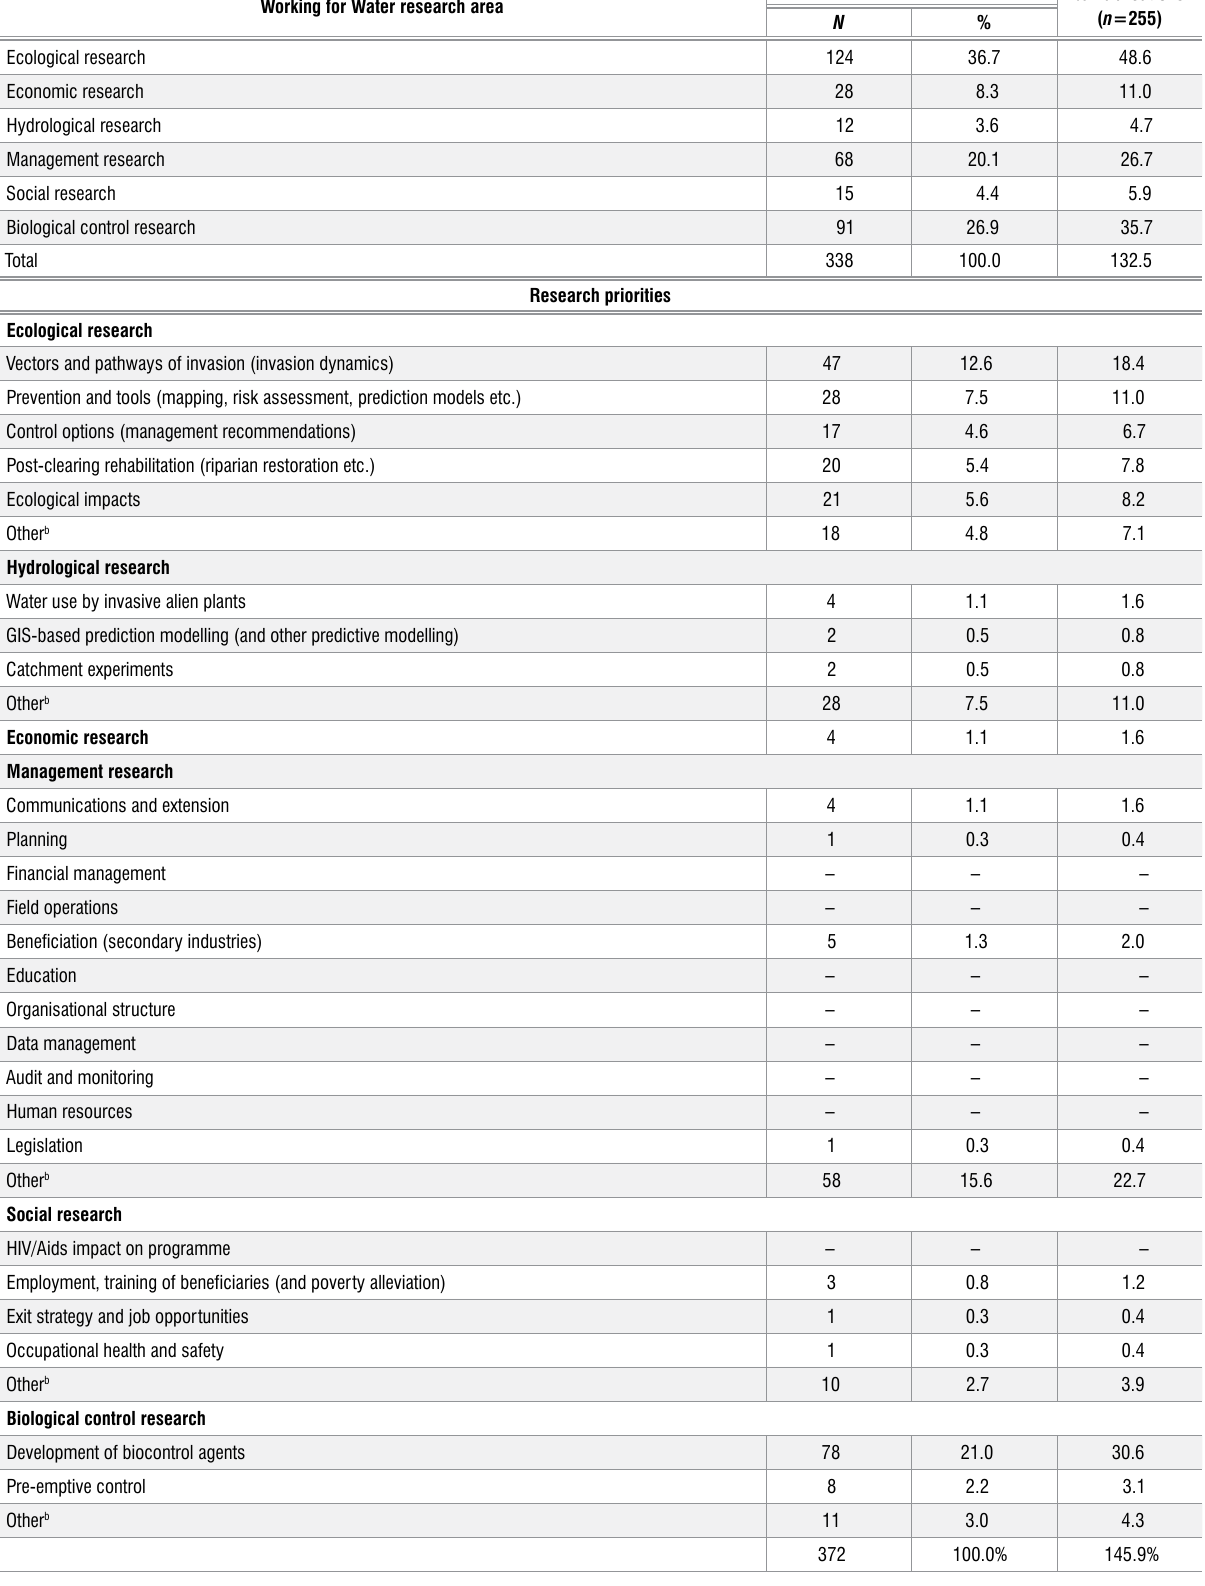
Table 2: Working for Water programme related publications categorised by research areas and priorities obtained from the 2005 research strategy 26 (using deductive content analysis). Number and percentage of total publications assigned to research areas and research priorities are reported. Working for Water research